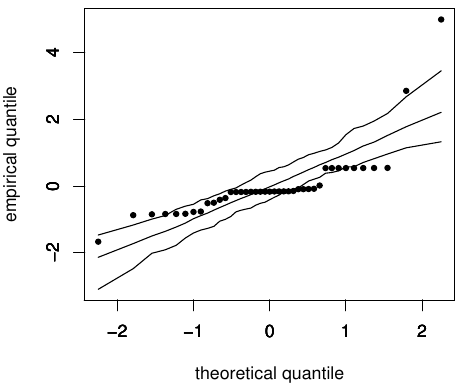
Figure 2. QQ plot with envelopes of the Pearson residual for normal regression with the data of times to electrical